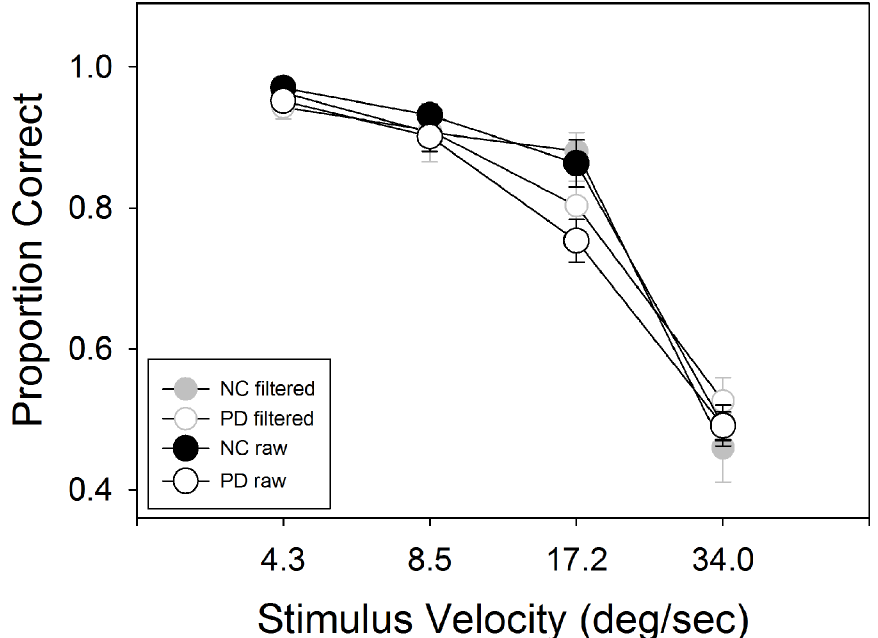
Fig 2. Results of Experiment 1. PD showed lower accuracy than NC overall (p = .049) for the raw dataset, but not when using the filtered dataset based on only trials where subjects maintained